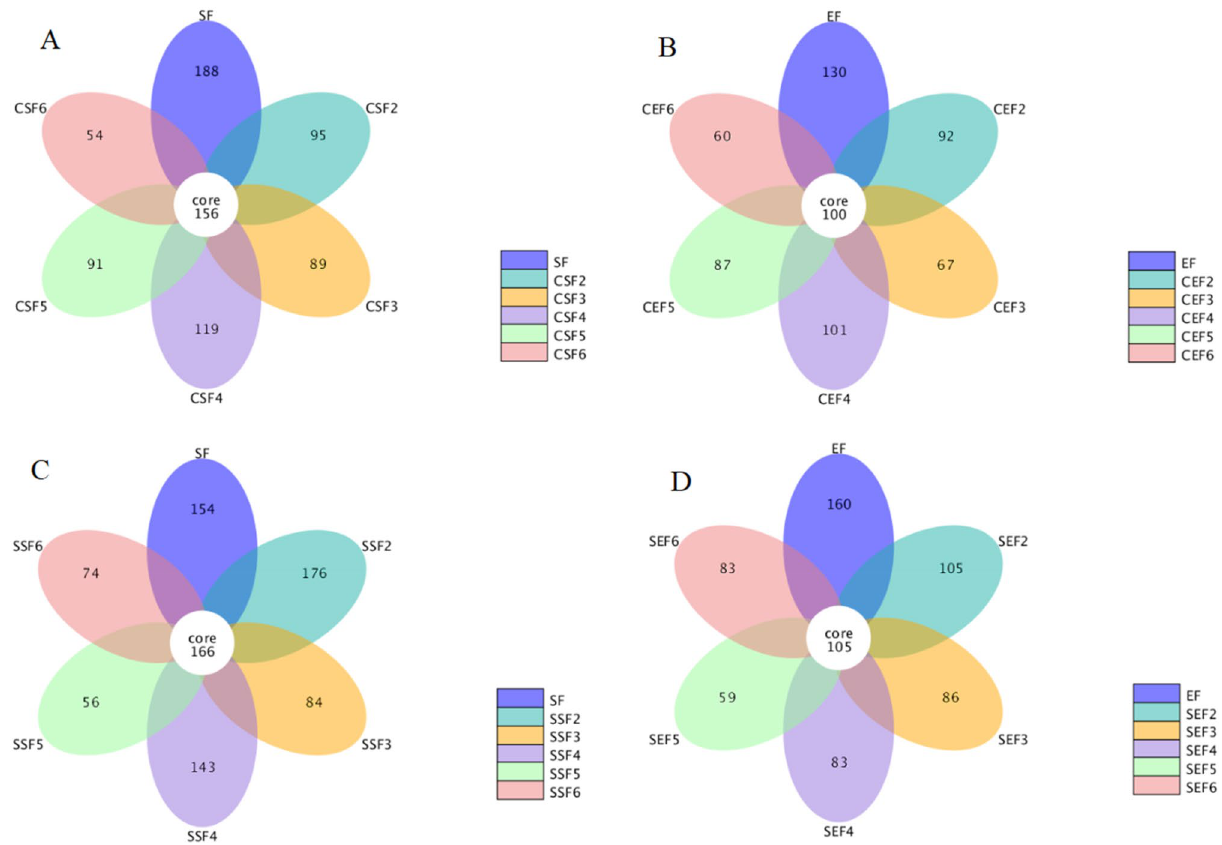
Figure 4. Petal diagrams of OTUs of fungi in samples flue-cured by using conventional procedure and temperature- and humidity-controlled procedure in different sampling stages (SB: the surface fungi of fresh tobacco leaves; EB: endophytic fungi of fresh tobacco leaves; CSB: the surface fungi of tobacco leaves flue- cured using conventional procedure; CEB: endophytic fungi of tobacco leaves flue-cured using conventional procedure; SSB: the surface fungi of tobacco leaves flue-cured using temperature- and humidity-controlled procedure; SEB: endophytic fungi of tobacco leaves flue-cured using temperature and humidity-controlled procedure; 2–6 denote different sampling